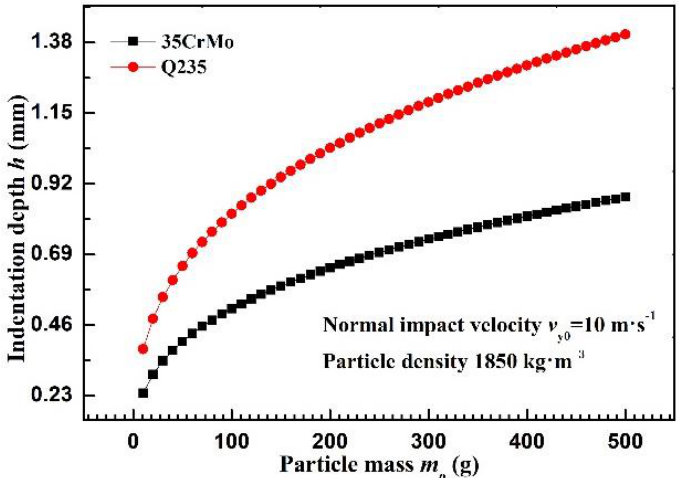
Figure 6. Indention depth versus particle mass for 35CrMo and Q235 wall.